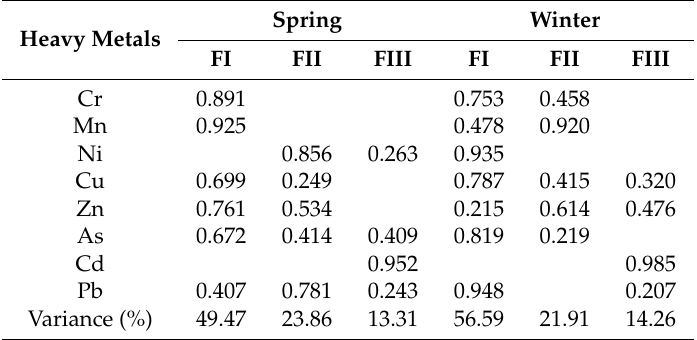
Table 4. Principal component analysis (PCA) results of heavy metals in PM 2.5 at